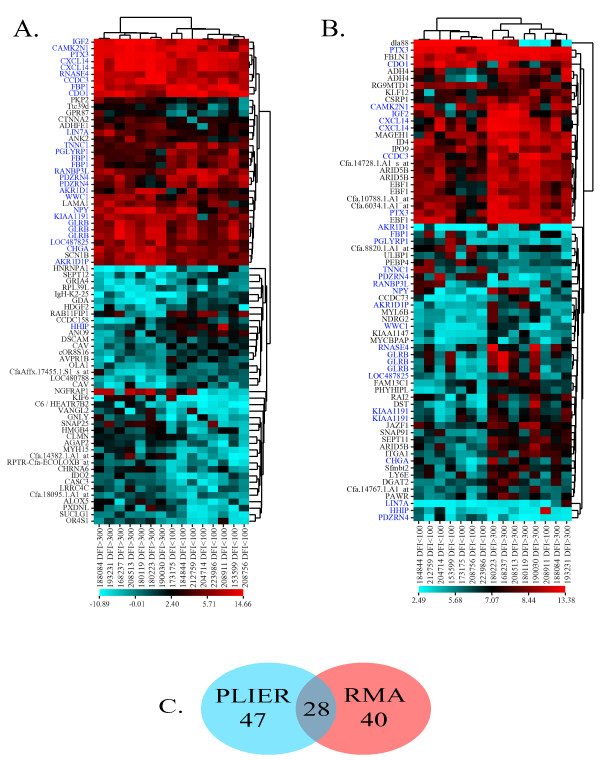
Fold change analysis of microarray data. Clustered image maps derived from gene array analysis of 15 canine osteosarcomas. Data was preprocessed with PLIER (A) and RMA (B) algorithms. Probesets were selected based upon fold change > 3 (PLIER) or > 2 (RMA) and an uncorrected p-value < 0.05. (C) Number of probesets meeting selection criteria from each algorithm that were shared and unshared between the two.